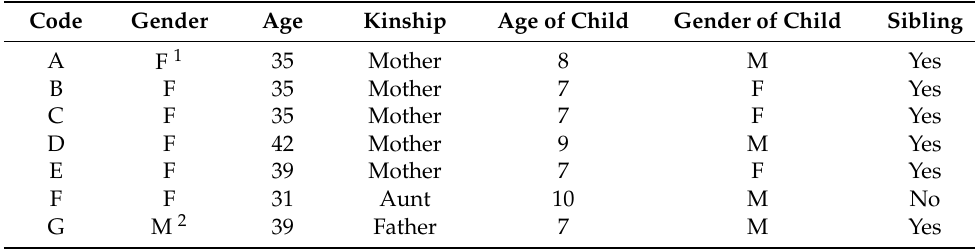
Table 2. Interviewee information.